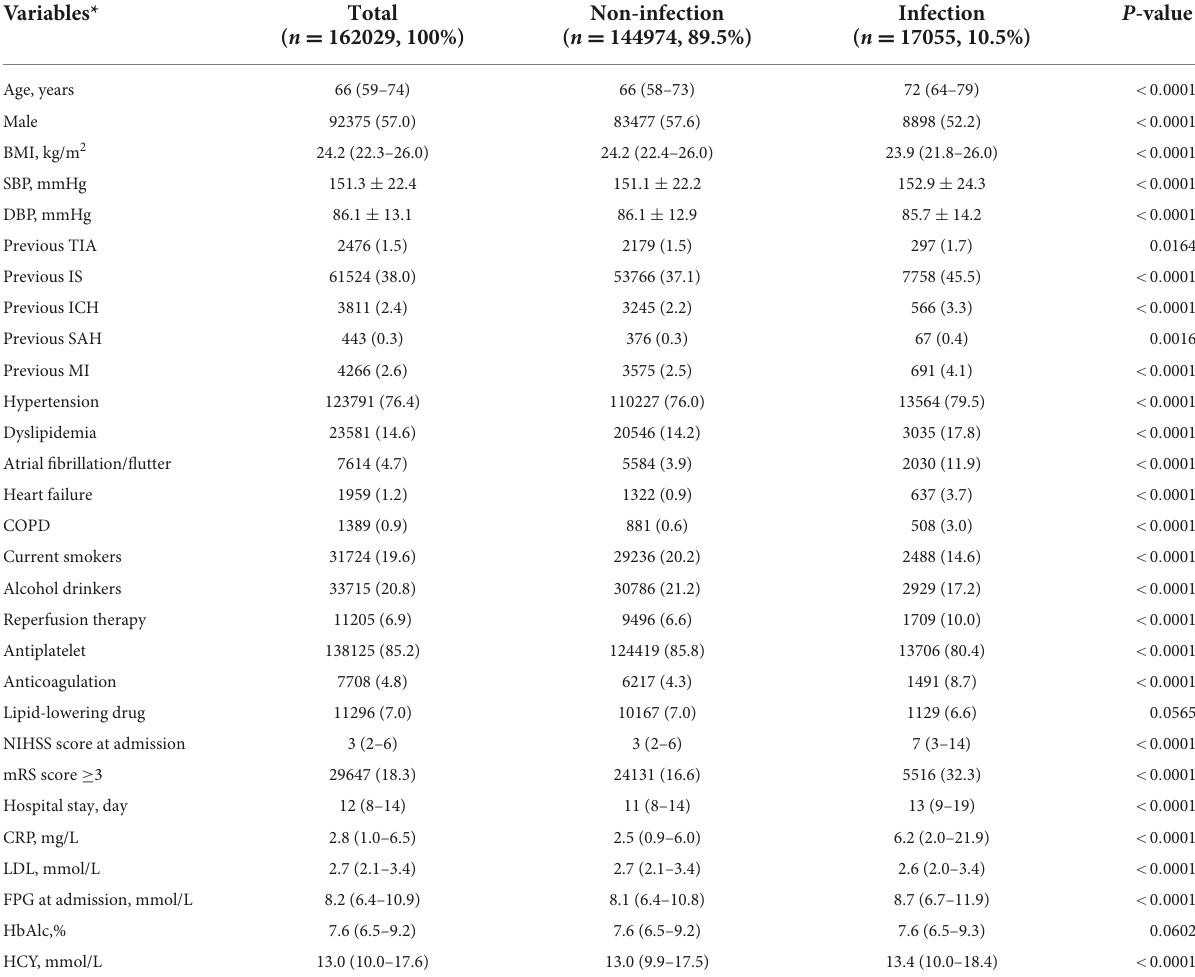
TABLE 1 Demographic and clinical characteristics of